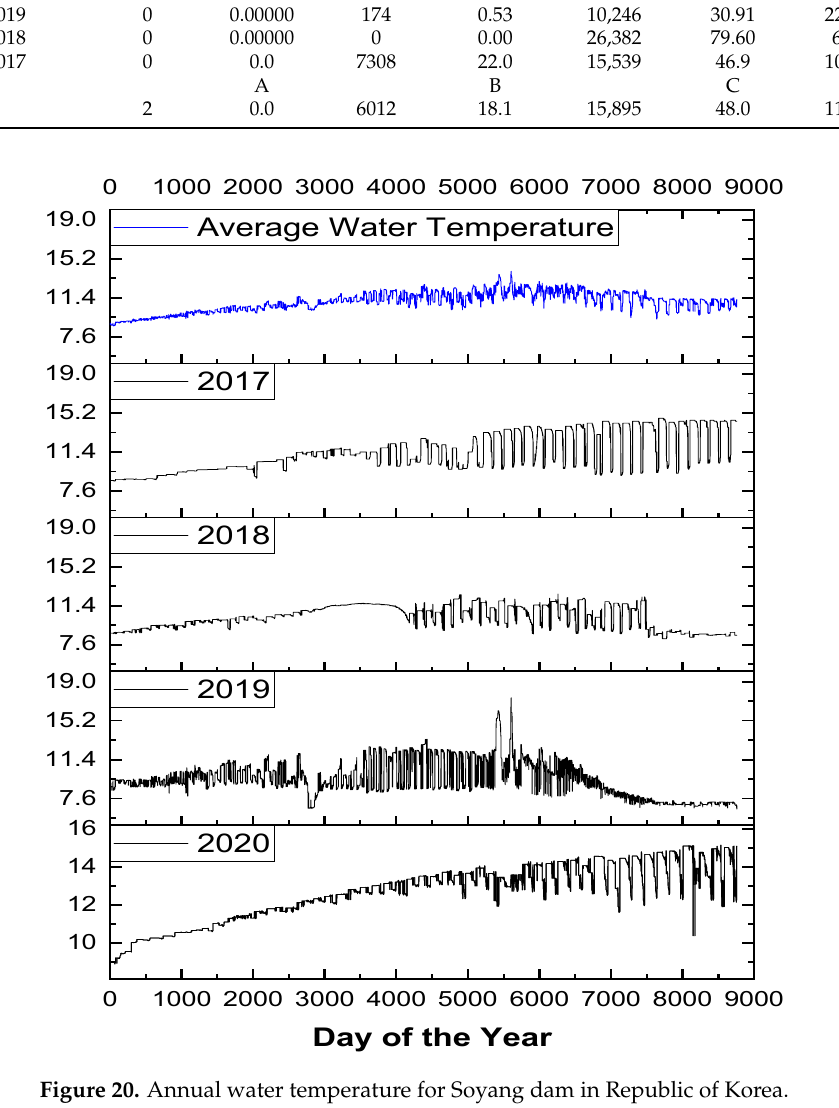
Figure 20. Annual water temperature for Soyang dam in Republic of Korea. Table 5. Summarized water data for Soyang dam.